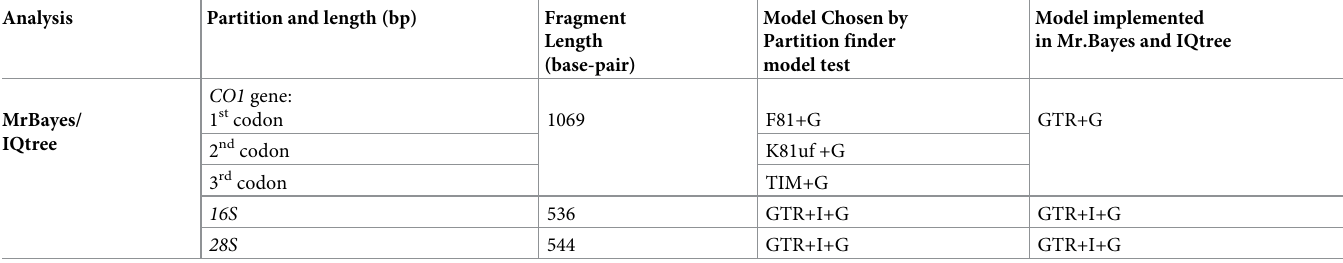
Table 3. Best schemes and models of gene partitions from partition finder. Analysis Model implemented